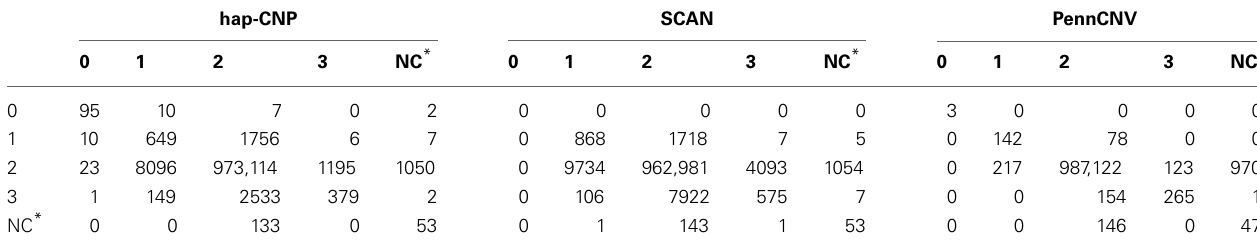
Table 5 | Concordance of copy numbers between duplicated samples.